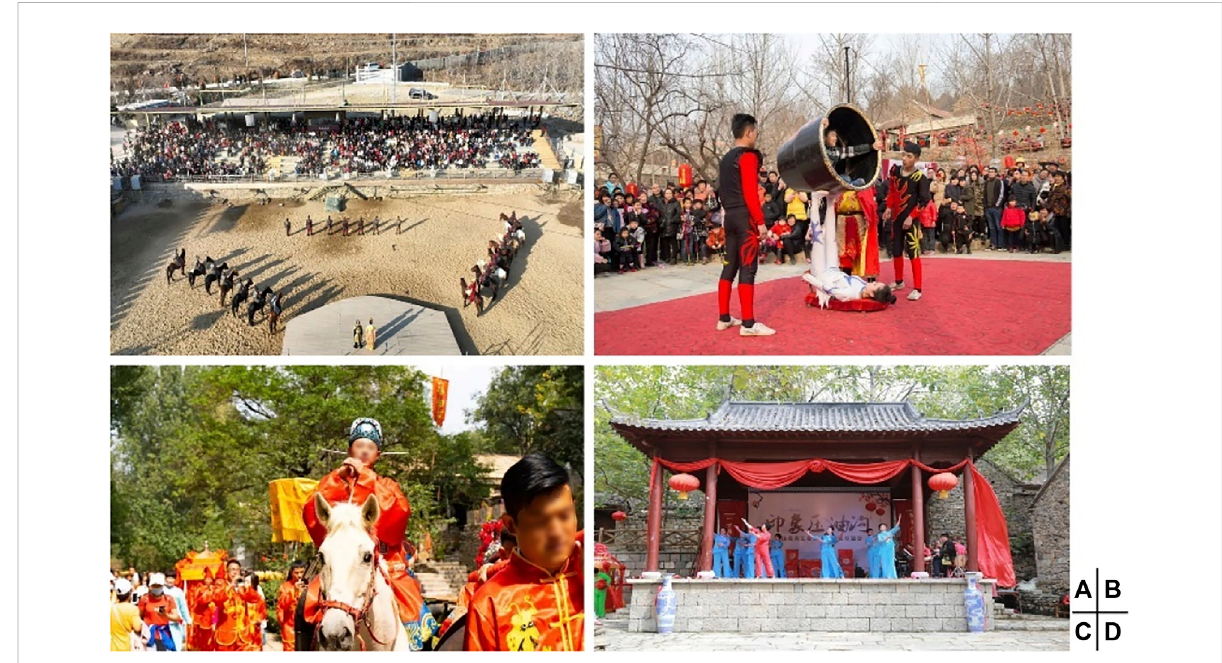
FIGURE 3 Examples of performance landscapes. (A) Animal show, (B) acrobatic show, (C) folklore performance, (D) local opera